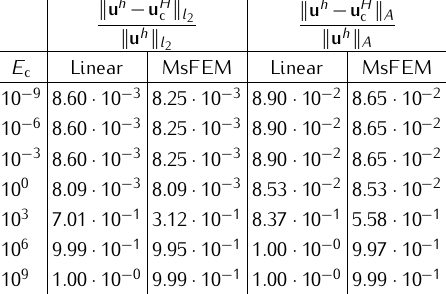
1 /h× 1 /h×H/h , h = 1 / 120 , H = 12